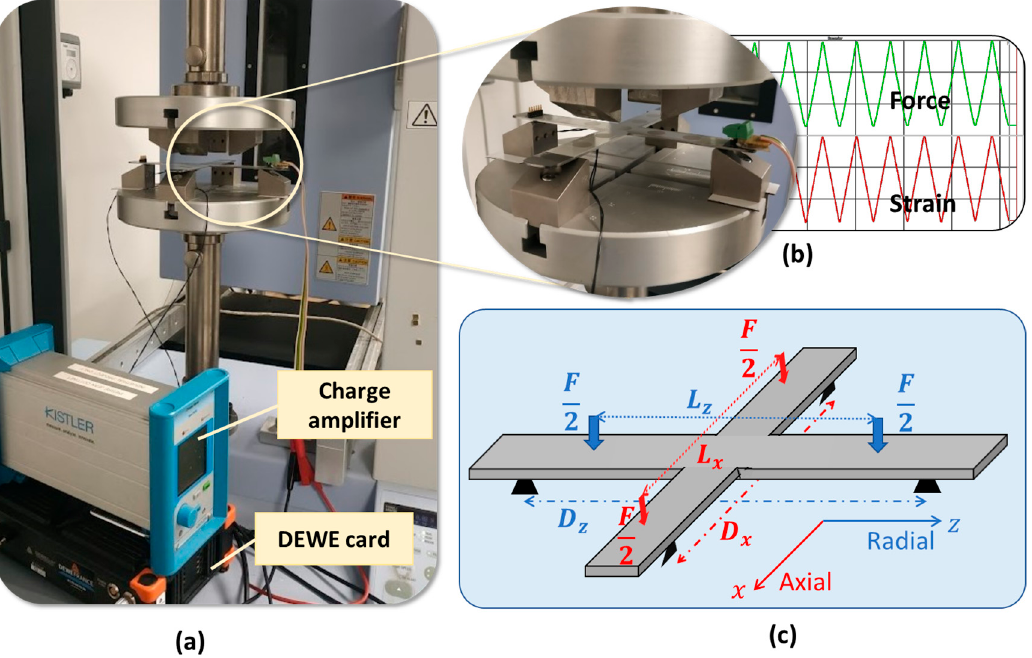
Figure 4. Setup of four-point bending (4PB) test using Shimadzu press: ( a ) measurement bench; ( b ) zoom-in on sample’s implementation; and ( c ) test could be performed by adjusting force and distance parameters in x - and z -axis.